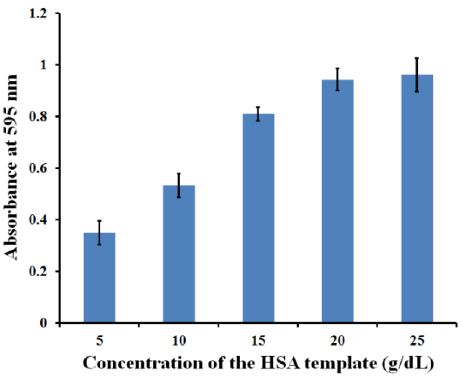
Figure 6. Absorbance of HSA-MIP (AA/VP ratio 2:3 ( w / w )) generated by the various concentra-tions of the HSA template.